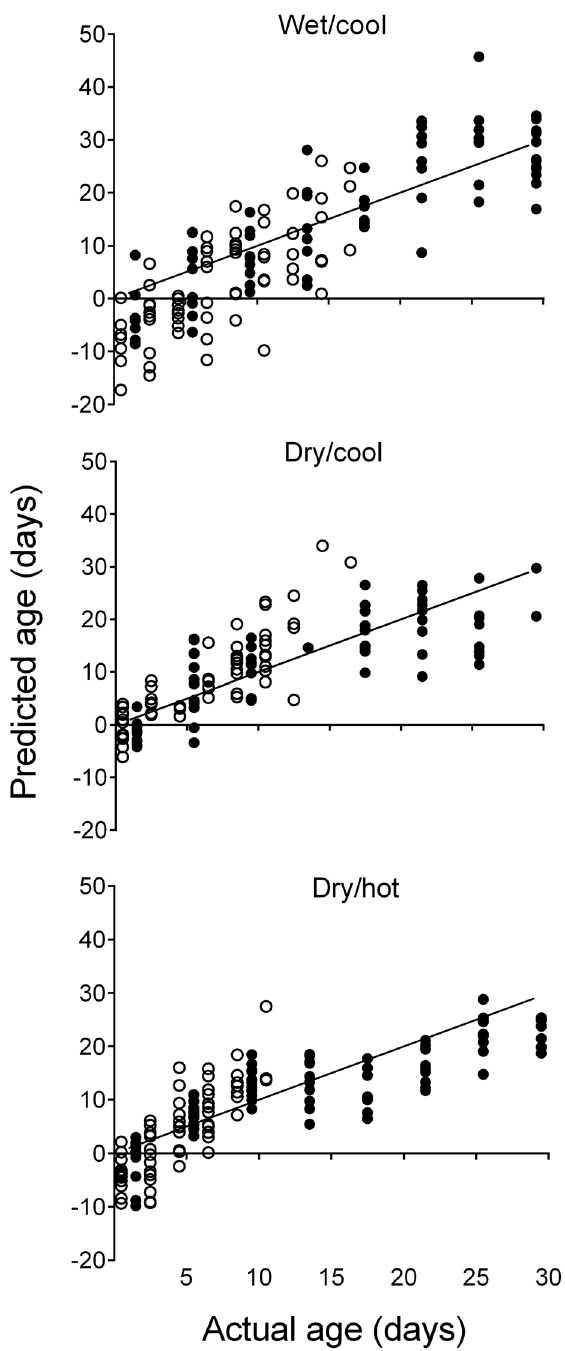
Figure 5. Age predictions of Aedes aegypti under seasonal ambient conditions in central Vietnam. The season specific redundancy variate models produced from caged mosquitoes in Tri Nguyen village were applied to estimate the age of free (open circles) and caged (closed circled) semi-field mosquitoes. Points indicate the mean of 1000 bootstrap replications of the redundancy analysis procedure for each sample, taken as the predicted age. The line shows where predicted age equals actual